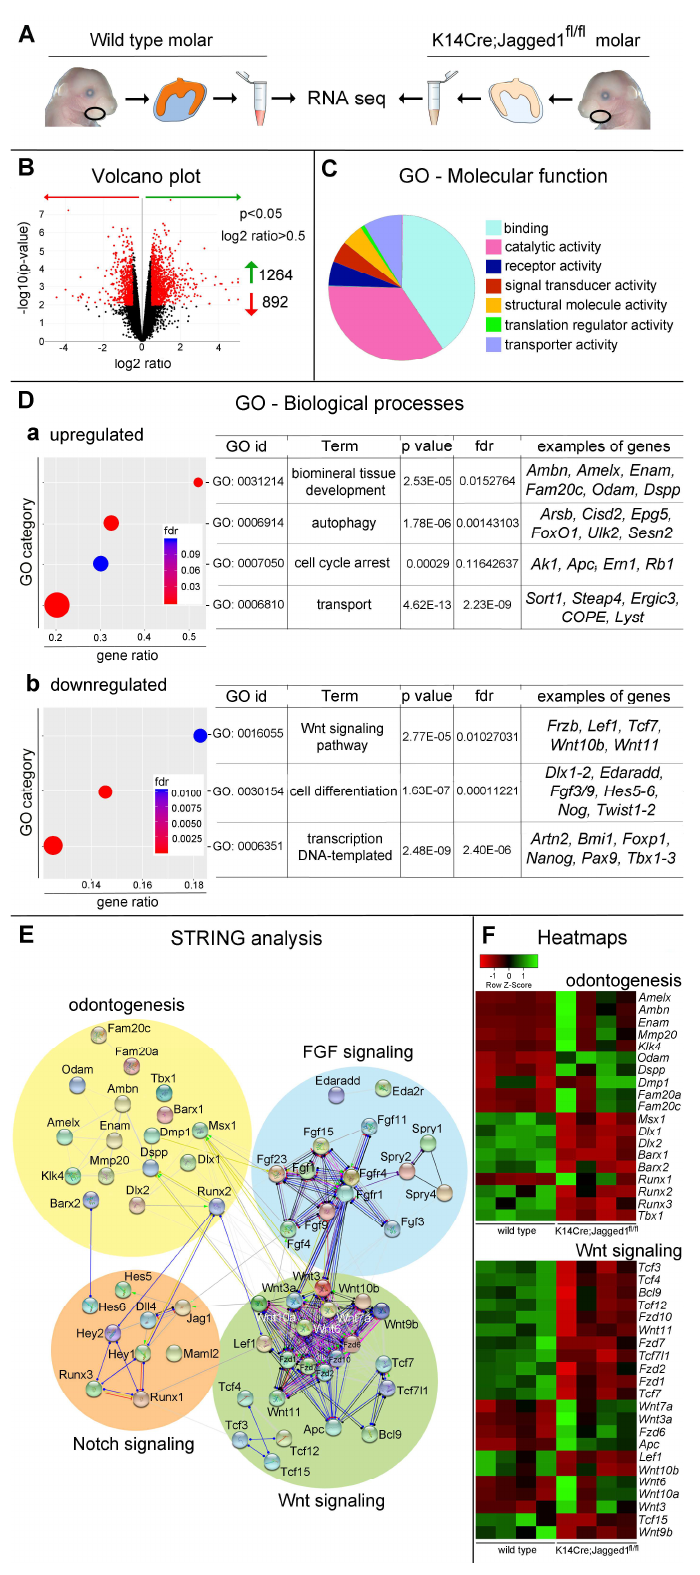
Figure 2. RNA sequencing analysis of first molars isolated from E18.5 WT and K14Cre;Jagged1 fl/fl mouse embryos. ( A ) Experimental approach. Molars were isolated from E18.5 K14Cre;Jagged1 fl/fl embryos and WT littermates. Their transcriptome was isolated via mRNA sequencing. ( B ) Volcano plot showing downregulated (red arrow) and upregulated (green arrow) genes in K14Cre;Jagged1